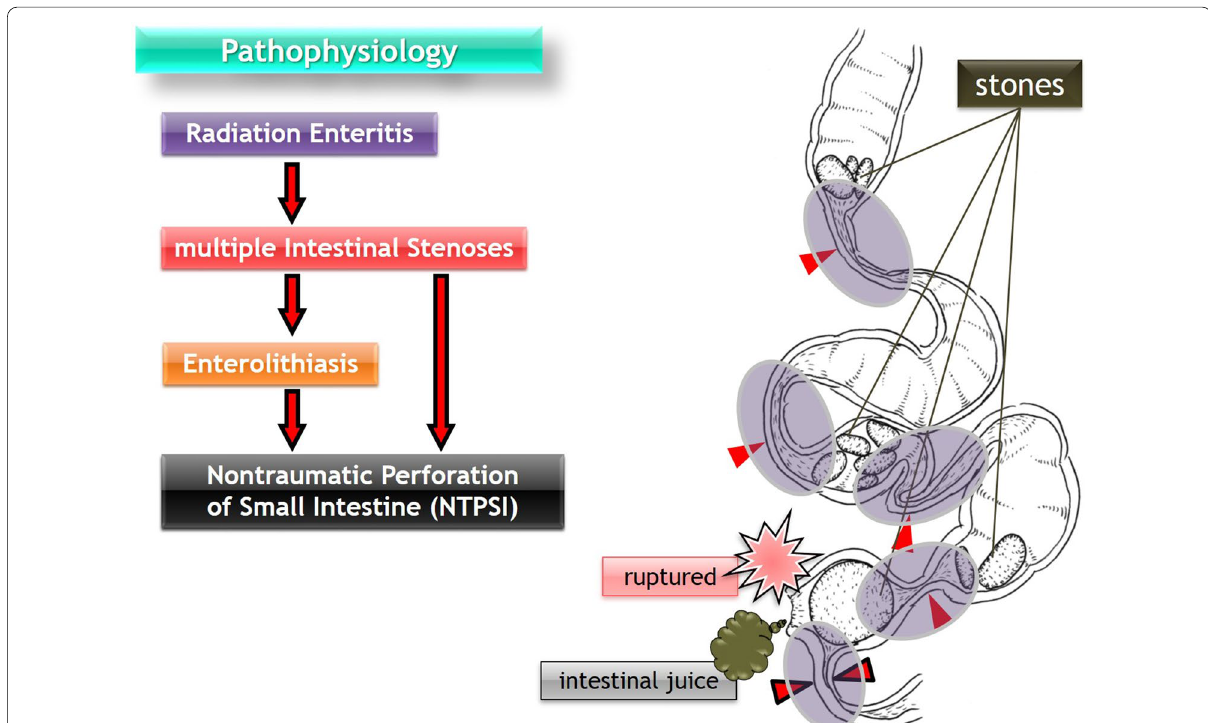
Fig. 6 Pathophysiological chart of the present case. Initially, radiation enteritis (purple shadowed circles) causes multiple strictures (red arrowheads) in the small intestine. Second, multiple true primary enteroliths arise in the prestenotic area as a result of intestinal stasis. Finally, the narrowest stenotic lesion (red arrowheads bordered in black) itself or impaction of the enterolith in the stricture causes nontraumatic perforation of the small intestine